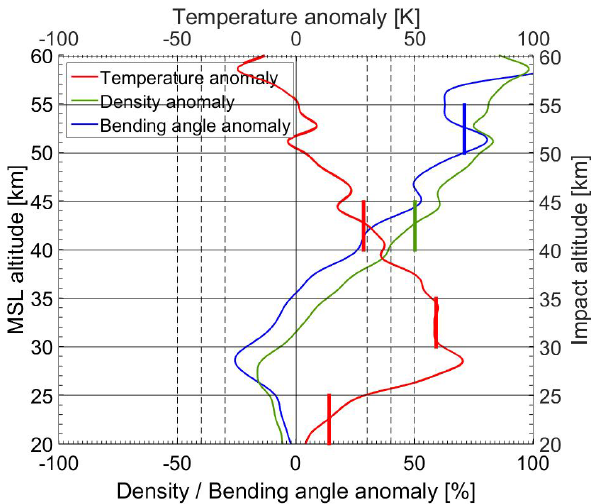
Figure 3. Temperature (blue), density (green) and bending angle (red) anomaly profiles of Event 1 (same as in Figs. 1 and 2), with the horizontal gray lines delineating the altitude layers chosen for calculating the five basic TEAs (Table 1, (4)–(8)) and the colored vertical thick lines indicating the vertical mean anomaly values in corresponding altitude